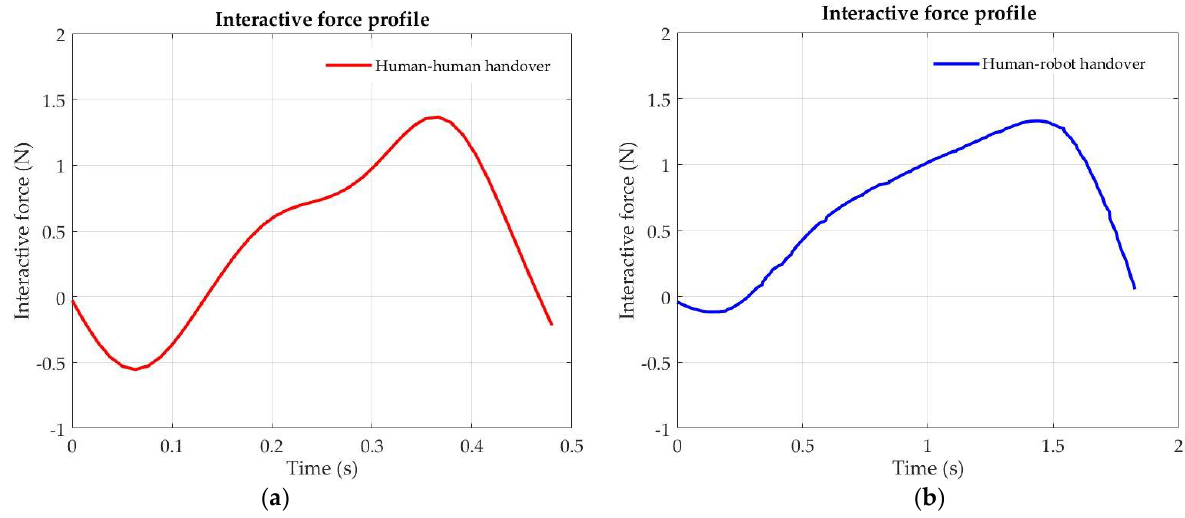
Figure 10. Interactive force profiles against the time of ( a ) the HHH test and ( b ) the HRH test.